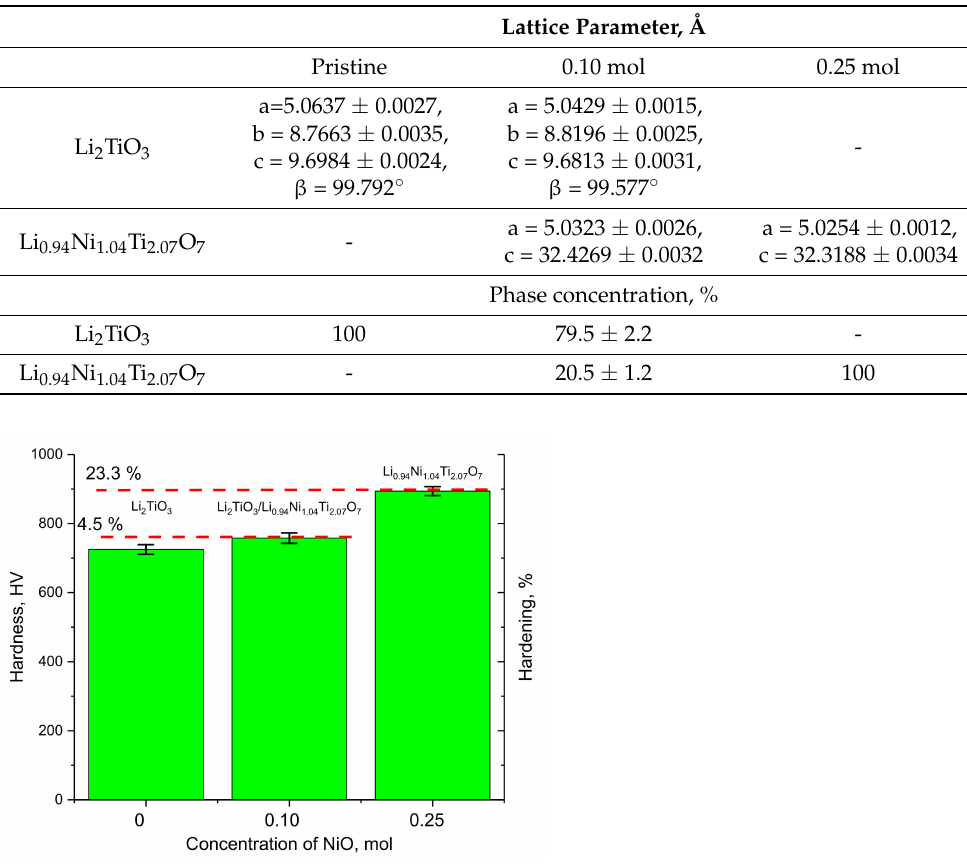
Table 1. The results of changing the parameters of the crystal lattice and the ratio of the phase composition of ceramics, depending on the concentration of the dopant.